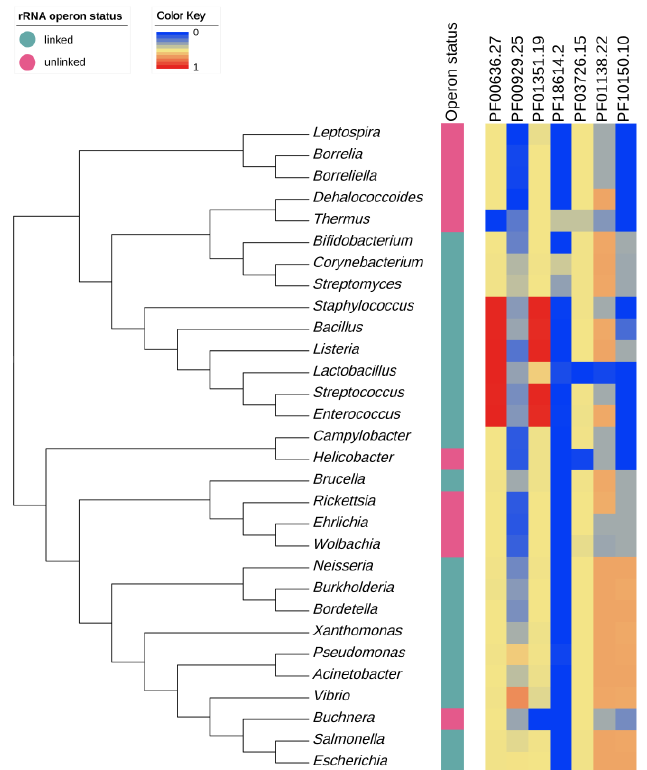
Figure 8. Heatmap drawn based on the number of RNases in the 30 genera. The phylogenetic relationship was determined by randomly selecting one genome for each genus and pruning it from the tree made by GTDBtk. After calculating the maximum number of each Pfam in all the genomes belonging to 30 genera, the relative amount was expressed as a heatmap. Pfam family: PF00636.27, Ribonuclease_3; PF00929.25, RNase_T; PF01351.19, RNase_HII; PF18614.2, RNase_II_C_S1; PF03726.15, PNPase; PF01138.22, RNase_PH; PF10150.10, RNase_E_G.